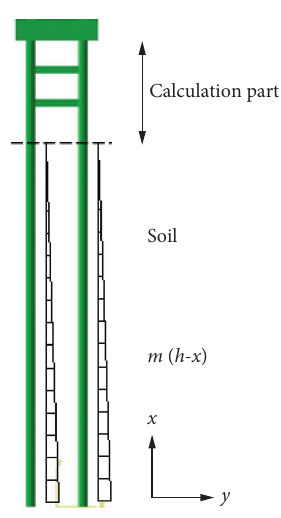
Figure 5: Finite element analysis